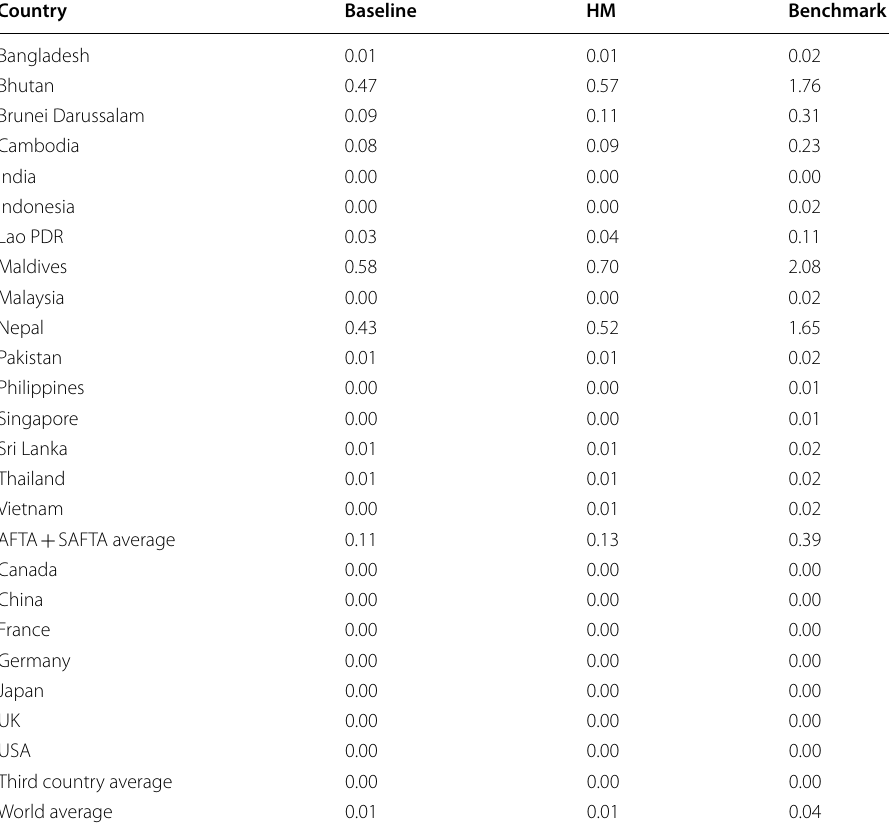
Table 7 Conditional GE effect of SAFTA Source Authors’